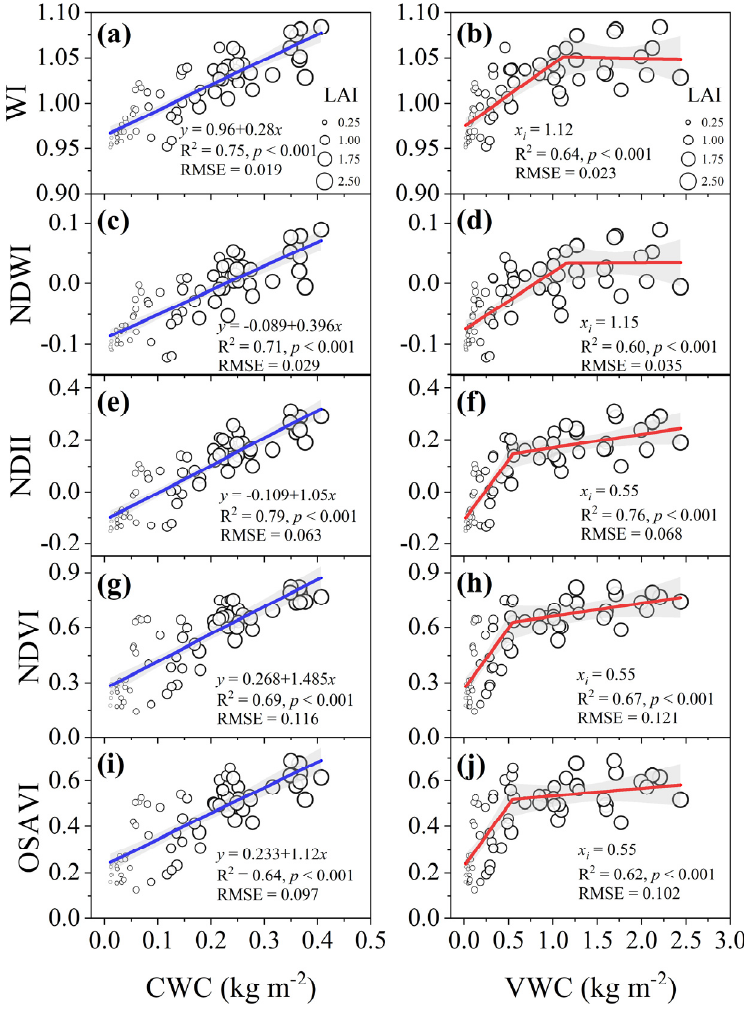
Figure 5. Response of the spectral vegetation indices to canopy water content (CWC) and vegetation water content (VWC) during soil drying. ( a ) WI, ( c ) NDWI ( e ) NDII, ( g ) NDVI, and ( i ) OSAVI response to CWC, respectively. ( b ) WI, ( d ) NDWI, ( f ) NDII, ( h ) NDVI, and ( j ) OSAVI response to VWC, respectively. Linear and nonlinear regression lines show the 95% confidence intervals. RMSE, root mean square error.